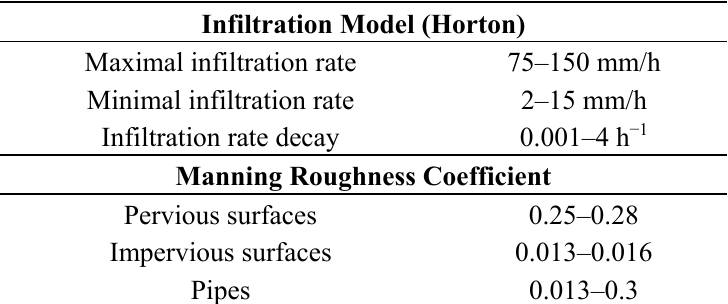
Table 6. Parameters of the SWMM